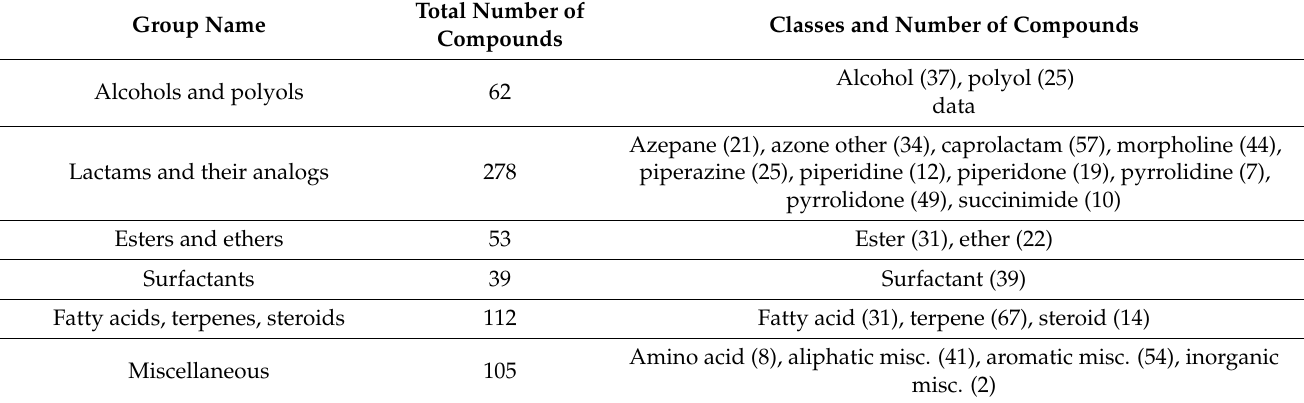
Table 1. Structure and classification of molecules in